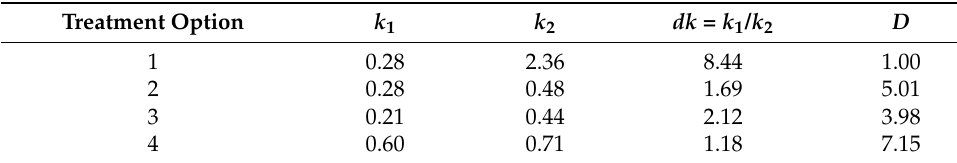
Table 2. The results of calculating the values of k , dk , and D